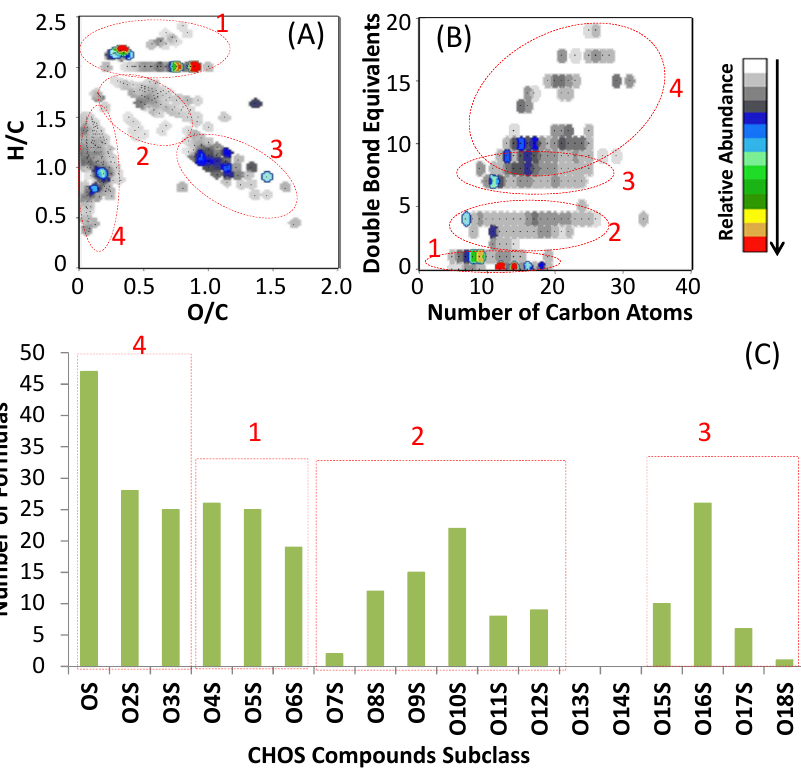
Fig. 6. Isoabundance van Krevelen diagram for CW1 CHOS compounds (a) . Isoabundance plot of DBE vs. number of carbon atoms in molecular formulas for CW1 CHOS compounds (b) . Number of formulas identified in each of the CW1 CHOS subclasses (c) . The red circles and boxes indicate the approximate groupings (1 to 4) of the CW1 CHOS formulas. The corresponding figures for CW2 CHOS compounds are shown in Fig.